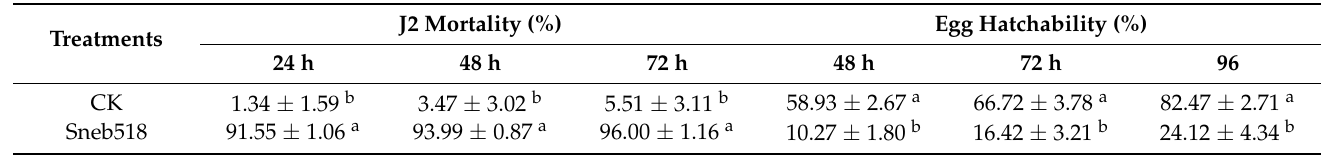
Table 2. Second screening of Sneb518 for J2 mortality and egg hatchability.